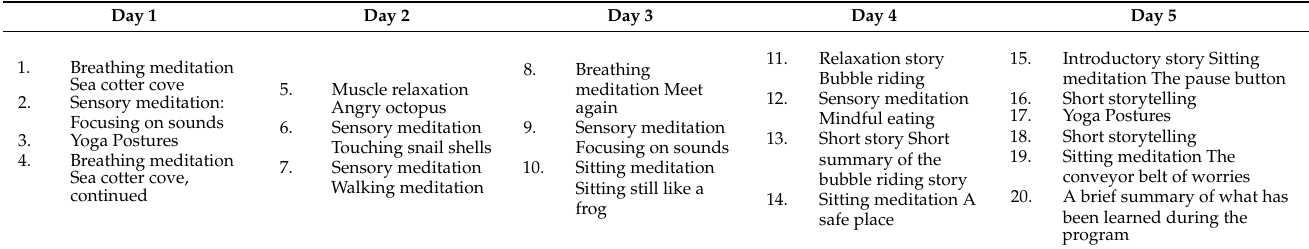
Table A2. Schedule of the